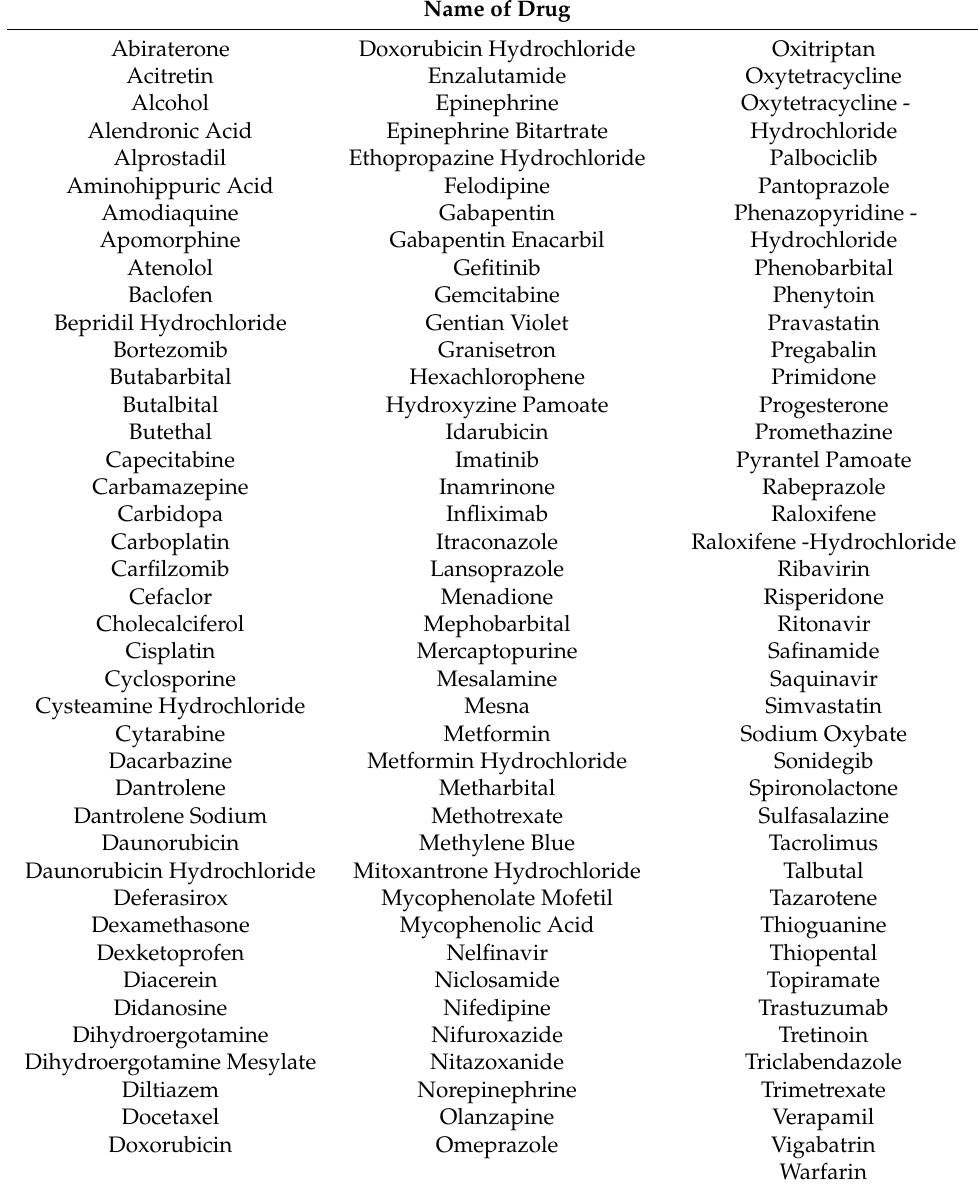
Table 1. List of proposed drugs with use approvals for both MDD and